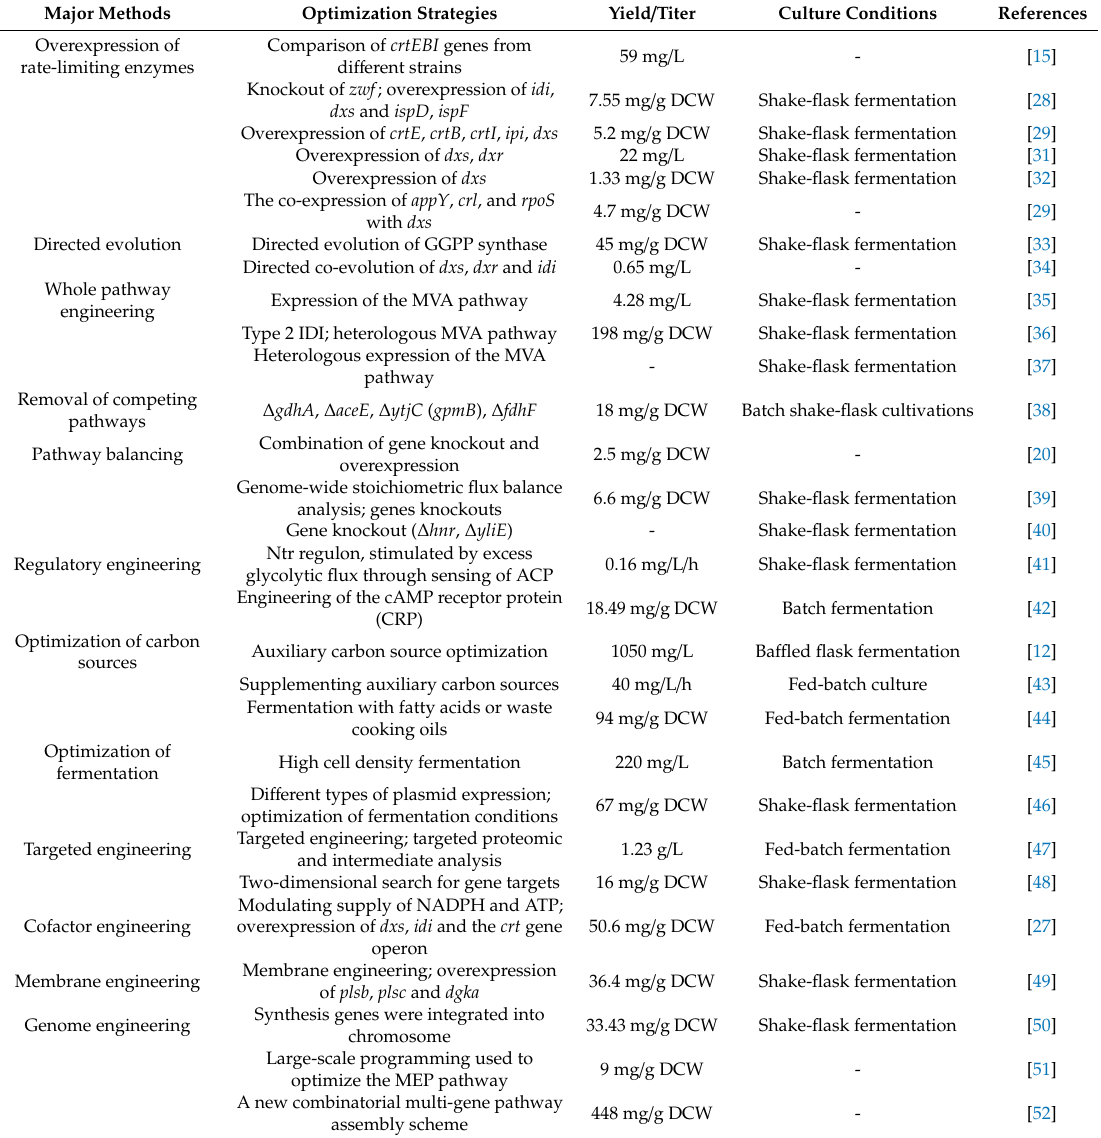
Table 1. Summary of the metabolic engineering optimization strategies used for the production of lycopene in E. coli